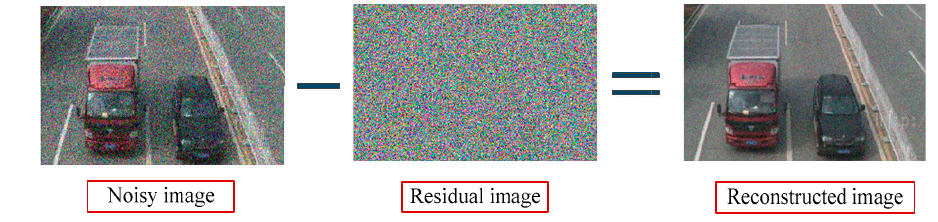
Figure 3. Reconstruction phase of the proposed model.